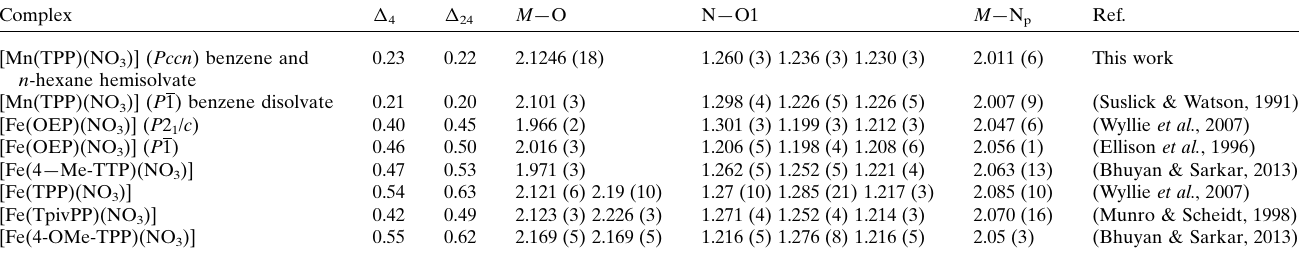
Table 1 Selected structural parameters (A˚ ) for related metalloporphyrin nitrato complexes. (cid:2) 4 is the displacement of the metal atom from the mean plane of the four pyrrole nitrogen atoms and (cid:2) 24 is the displacement of the metal atom from the 24-atom mean plane. Complex (cid:2) 4